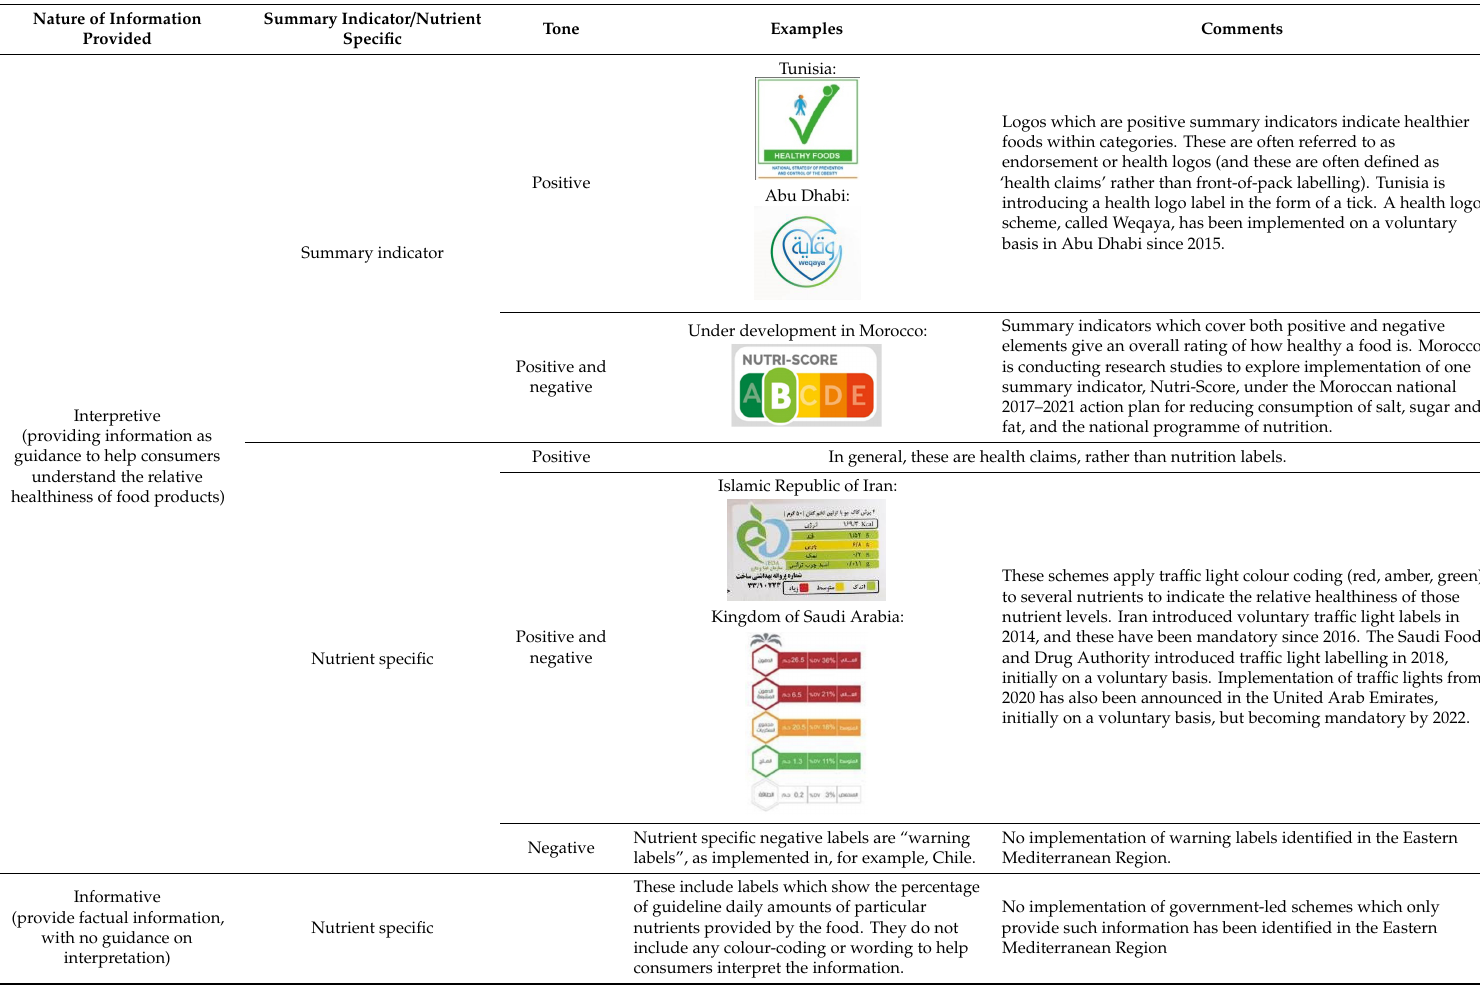
Table 2. Different types of front ‐ of ‐ pack nutrition labelling schemes in use or under development in the WHO Eastern Mediterranean Region. Nature of information provided